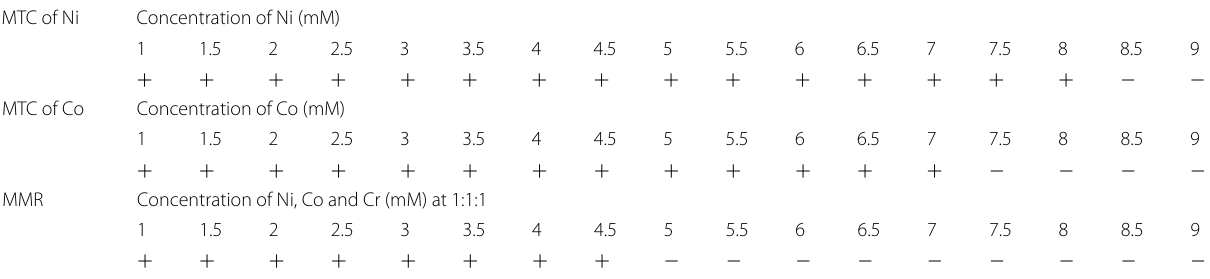
Table 1 Maximum tolerable concentration and multi metal resistance shown by AMIC1 against heavy metals MTC of Ni Concentration of Ni